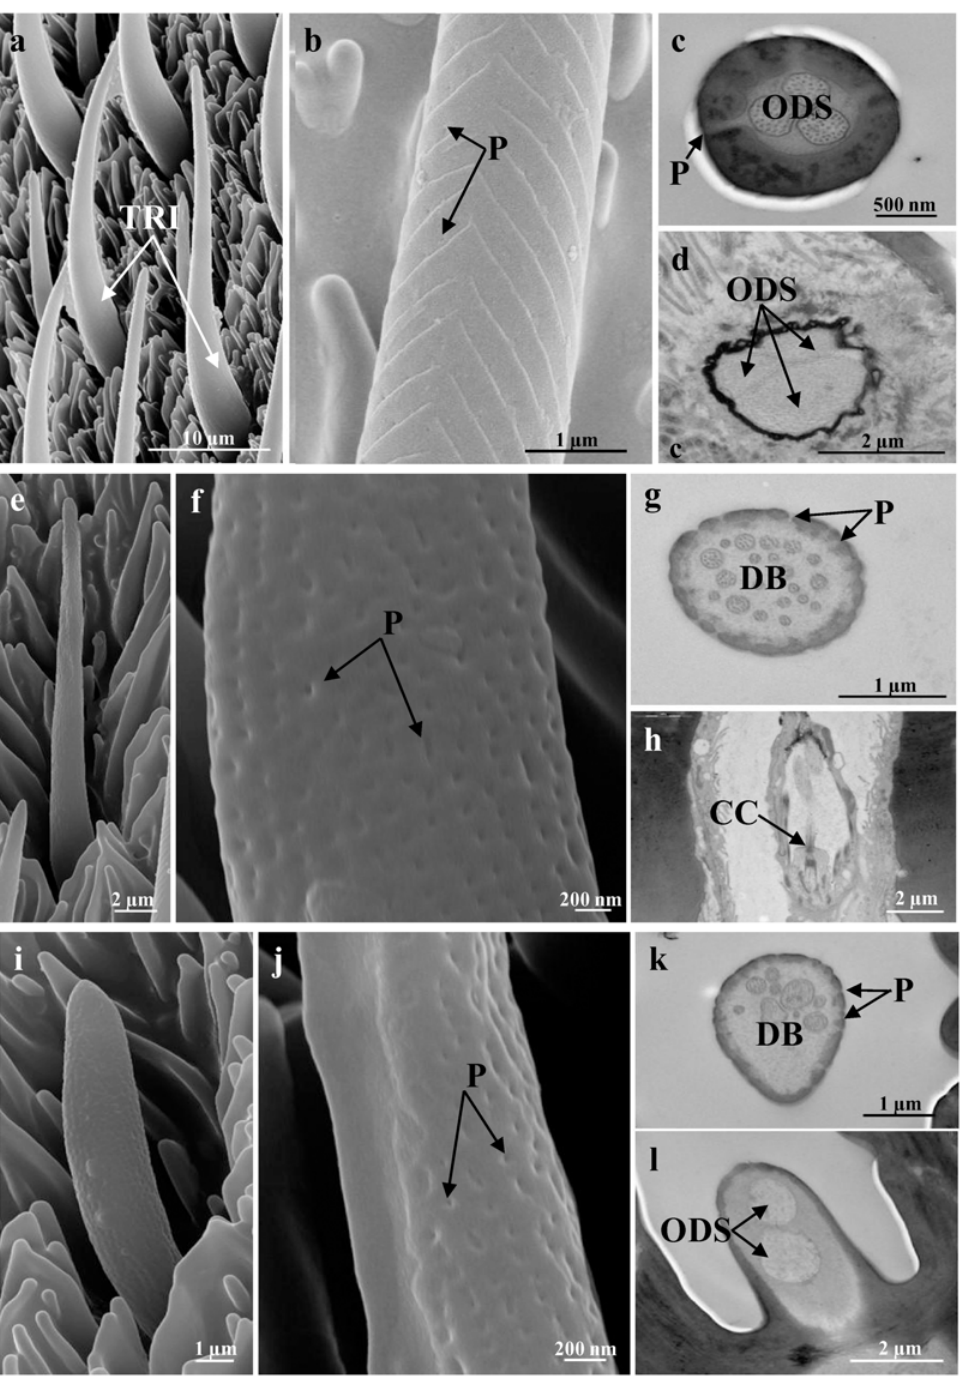
Fig 2. Representative SEM (a, b, e, f, i, j) and TEM (c, d, g, h, k, l) images of the more numerous sensilla. (a-d) Sensilla trichoidea, showing low- magnification details (a), herringbone grooves and pores [P] (b), and cross-sections of the shaft with thick-walled cuticle [P] and outer dendritic segments [ODS] with three sensory neurons (c), and of the base with three sensory neurons enclosed in a common dendritic sheath [ODS] (d). (e-h) Sensilla basiconica, showing low-magnification details (e), the numerous pores [P] (f), cross-section of the shaft with the thin-walled cuticle [P] and the dendritic branches [DB] (g), and an oblique section of the base with the ciliary constriction [CC] (h). (i-l) Sensilla auricilica, showing low-magnification details (i), the numerous pores [P] (j), cross-section of the shaft with the thin-walled cuticle [P] and dendritic branches [DB] (k), and an oblique section of the base, with two sensory neurons enclosed in a common dendritic sheath [ODS] (l). Scale bars: 10 μ m (a); 2 μ m (d, e, h, l); 1 μ m (b, g, i, k); 500 nm (c); 200 nm (f, j).